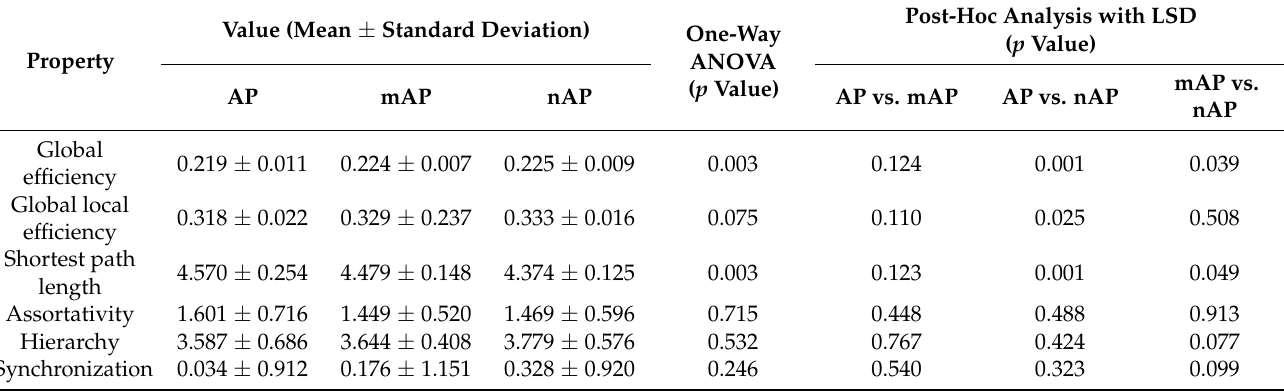
Table 2. Summary of Global topological properties.